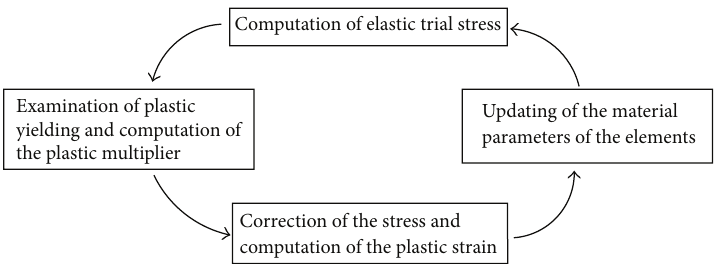
Figure 3: Procedure of the numerical computation used in